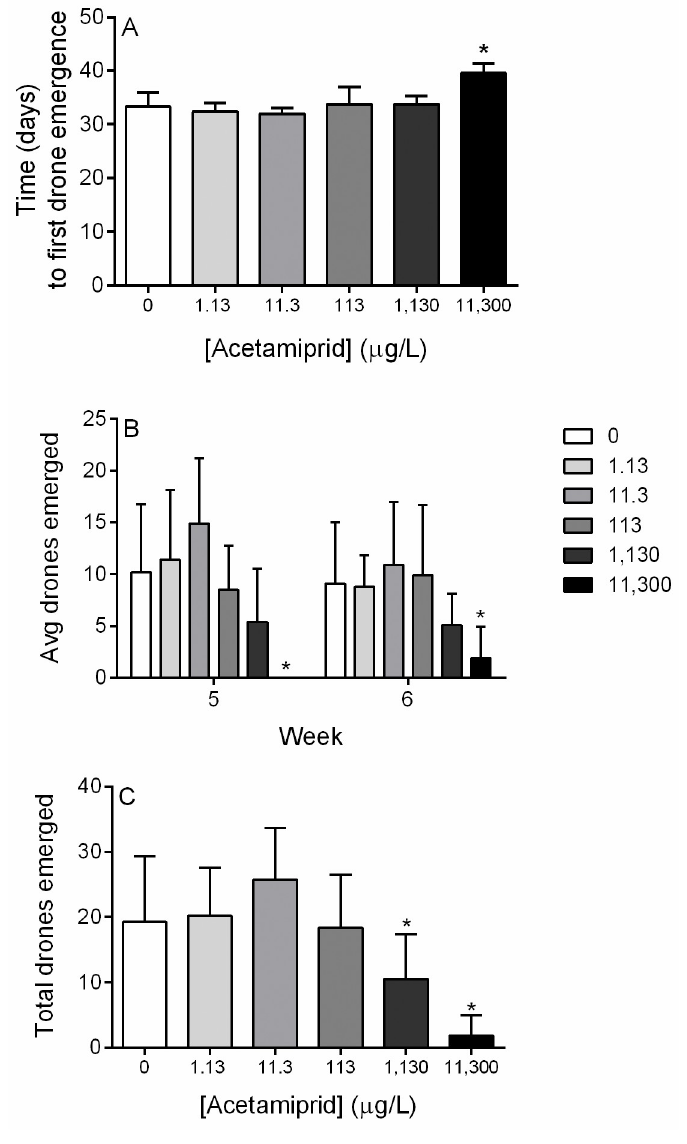
Fig 5. Microcolony drone production. Drones were collected from each microcolony as they emerged. ( A ) Time to first drone emergence by treatment group. ( B ) Average drone emergence in week five and six by treatment group. ( C ) Average drone emergence from microcolonies for the entire experiment. Acetamiprid concentrations are expressed in μ g/L. Data shown as mean ± SD (n = 10). � denotes p < 0.05.